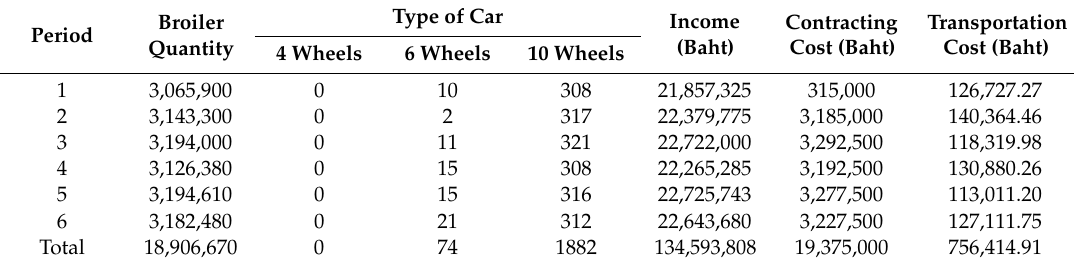
Table 6. Results of solving problems for the case study using the ALNS algorithm.